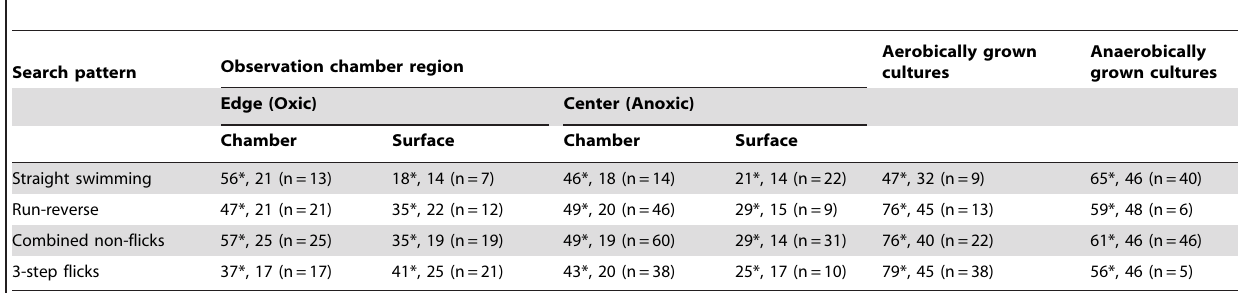
Table 1. Maximum, and mean search pattern speeds ( m m s 2 1 ) and total search pattern numbers (n) identified in oxic and anoxic regions of the observation viewing